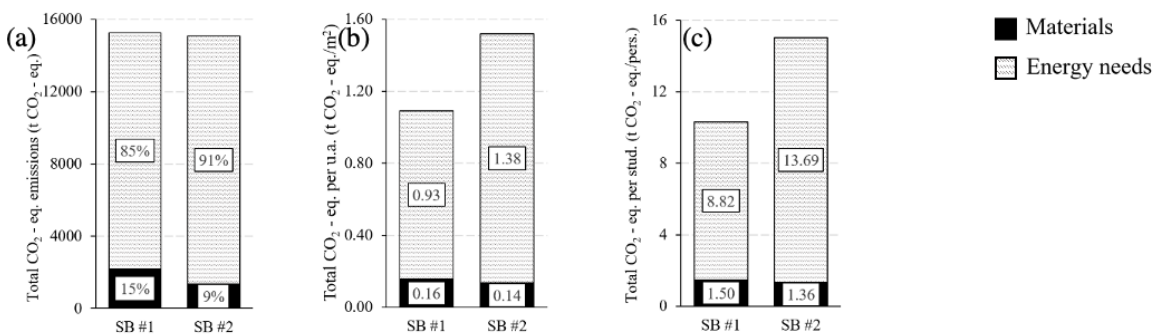
Figure 4. Comparison of overall CO 2 - eq. emissions marked by sources (material and energy needs): (a) total amount; (b) amount per unit of gross building area; (c) amount per